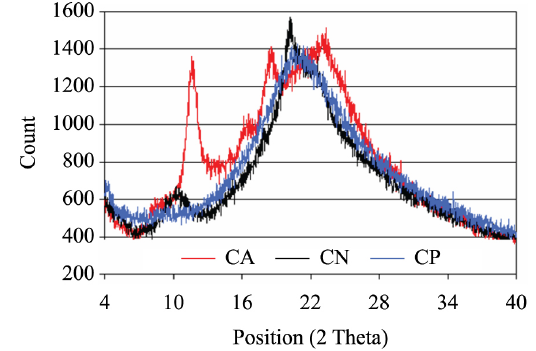
Figure 1. X-Ray diffractogram of membranes (CA - red, CN - black, CP –